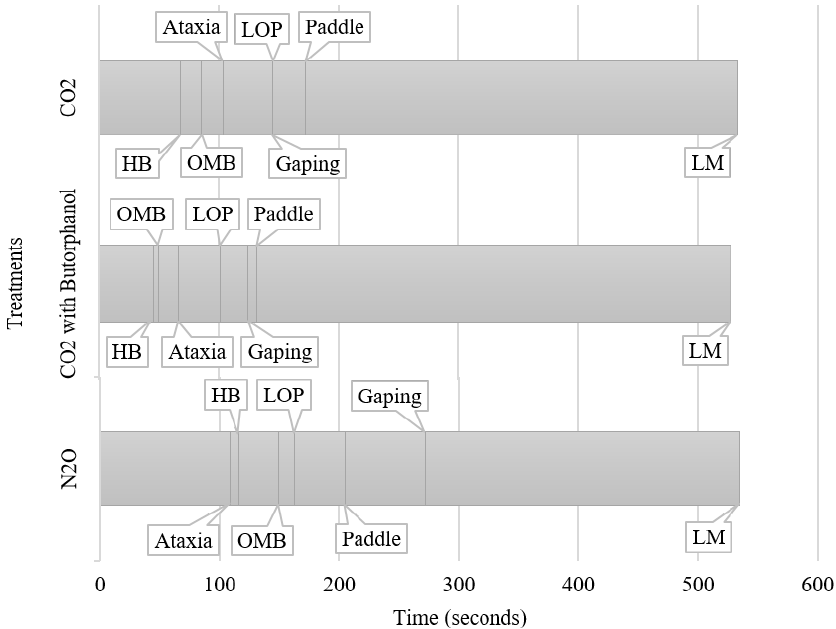
Figure 1. The sequence of behaviors (plotted from data in Table 3), showing latencies and durations, for pigs in each treatment: CO 2 , CO 2 with butorphanol, and N 2 O. Using the means of each latency, a timeline was created to highlight the difference in the order in which the behaviors occurred. HB = heavy breathing, OMB = open-mouth breathing, LOP = loss of posture, LM = last movement. Postural behaviors standing and lying were mutually exclusive; and the activity behaviors paddling, inactivity, and locomotion were mutually exclusive.